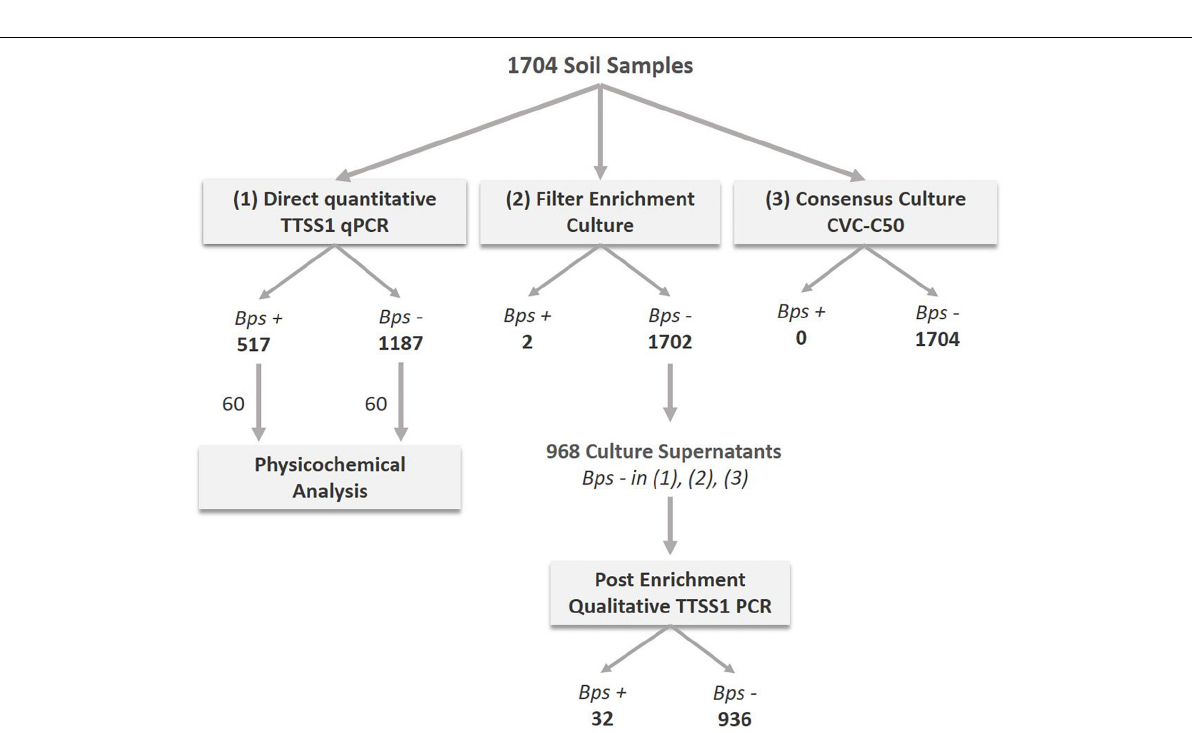
Frontiers in Microbiology |